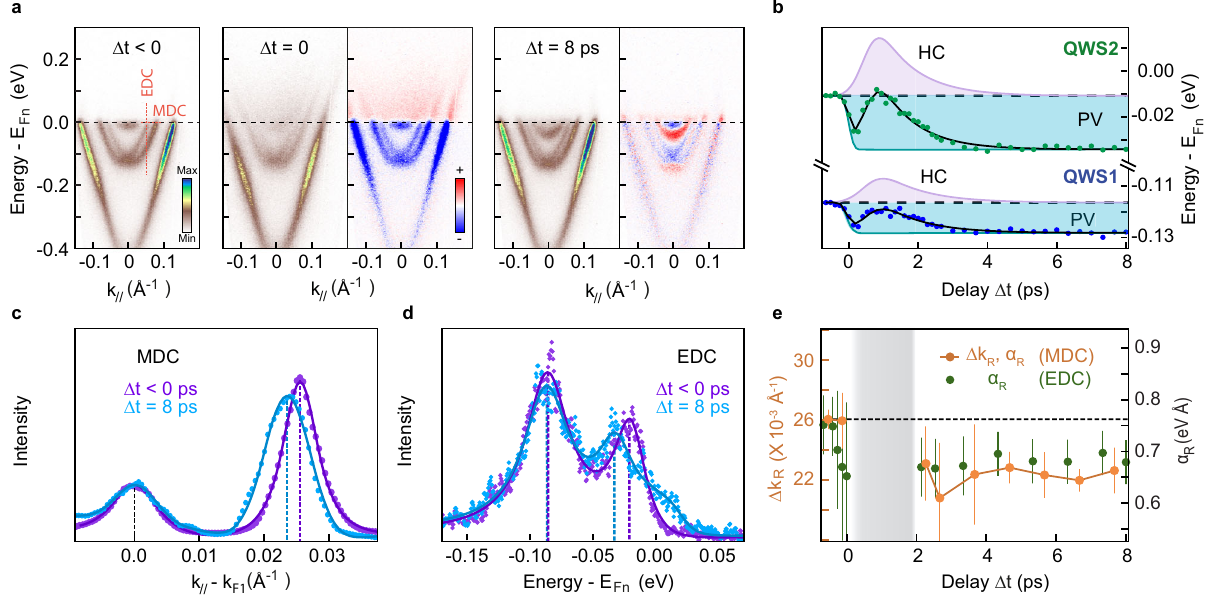
Fig. 3 Ultrafast response of Rashba QWSs to optical perturbation. a ARPES dispersion at negative time delay (before pump arrival), at time zero (pump and probe fully overlapped), and at 8 ps. The latter two are accompanied by differential spectra obtained by subtracting the spectrum acquired at around – 0.5 ps; the blue (red) color is indicative of a pump-induced decrease (increase) of photoemission intensity. b Temporal evolution of the energy minimum for QWS1 and QWS2 extracted from fi tting the ARPES data at k ∥ = 0. The fi t to the experimental data (solid black line) stems from two contributions, each consisting of a fi nite rise-time step function and an exponential decay. The positive contribution (purple) is de fi ned as a hot-carriers (HC) driven process, which is short-lived; the negative contribution (cyan) is the result of a photovoltage (PV) effect. c Momentum distribution curves (MDC) pro fi les across the right branch of QWS1 (horizontal dashed line in ( a )) at E Fn at equilibrium (purple) and after 8 ps (blue) relative to the Fermi wave-vector of the inner branch k F1 ; the solid lines are Voigt fi ts to the data. The momentum splitting Δ k R is the distance between two peaks of the same MDC, and it is dynamically reduced with the pump excitation from (26 ± 0.5) × 10 − 3 (at Δ t < 0) to (22.5 ± 0.5) × 10 − 3 Å − 1 (at Δ t = 8 ps). d Energy distribution curves (EDC) pro fi les across the inner and outer branch of QWS1 at k ∥ = 0.05 Å − 1 (vertical dashed line in a ) before pump arrival (purple) and after 8 ps (blue). The optical excitation also induces the reduction of the energy splitting. EDC and MDC pro fi les in ( c and d ) have been deconvolved by the energy resolution via Lucy- Richardson algorithm (Ref. 47 ) for better clarity. Both pro fi les are fi tted using Voigt functions (solid lines). e Temporal evolution of the RSOC strength α R in QWS1 calculated from Eq. (1) and extracted by fi tting the momentum (orange) and energy (green) splitting at several time delay; α R is reduced by about 0.1 eV Å at 8 ps with respect to equilibrium. The values of Δ k R at E Fn are explicitly plotted against the left axes. At 0 < Δ t < 2 the signal is too low to convey reliable physical signi fi cance. All the values of energy and momentum splitting are obtained by fi tting the raw data, and error bars are evaluated from statistical distribution within 95% con fi